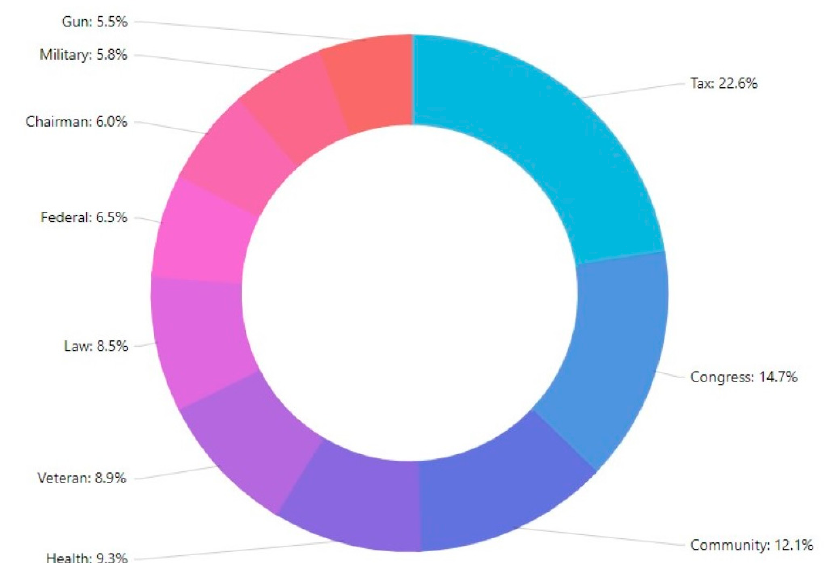
Figure 4. Distribution of the first ten political-legislative terms according to their occurrence.